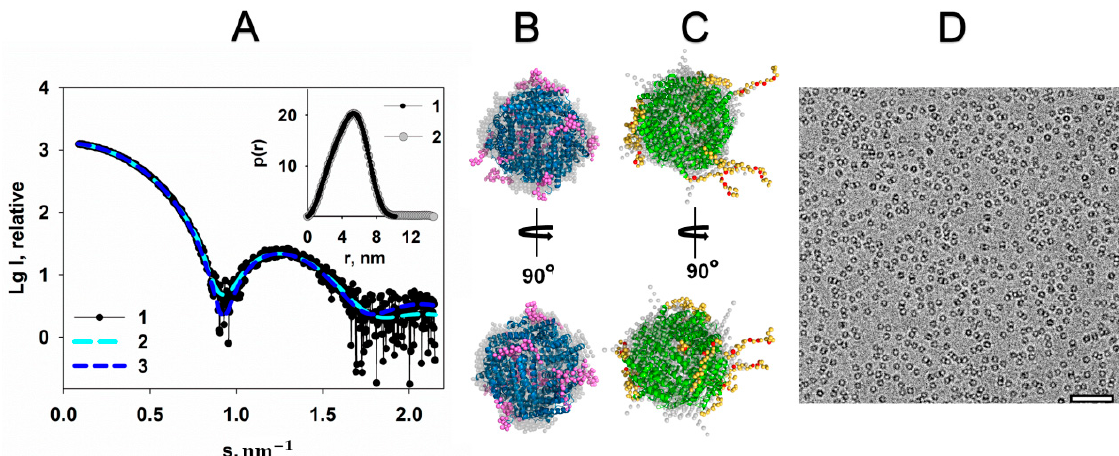
Figure 2. The effect of 20 mM MgCl 2 on the Dps structure. ( A ) The experimental scattering curve of the Dps protein in the presence of 20 mM MgCl 2 in solution (1), scattering from DAMMIN (2), and CORAL (3) models of Dps. Insert: the distance distribution function p(r) of Dps in the presence of 20 mM MgCl 2 (1), and Dps without MgCl 2 (2). ( B ) and ( C ) shows the superposition of the DAMMIN model (gray spheres) and the CORAL in two orientations for better visualization: blue ( B ) and green ( C ) helices—the high-resolution structure of the Dps protein (PDB ID: 1DPS); magenta ( B ) and yellow ( C ) spheres are reconstructed N-terminal regions. ( C ) The residues Lys5, Lys8, Lys10 and Arg18 are represented by red spheres in the CORAL model. ( D ) Cryo-EM data of Dps with MgCl 2 ; bar length is 50 nm.